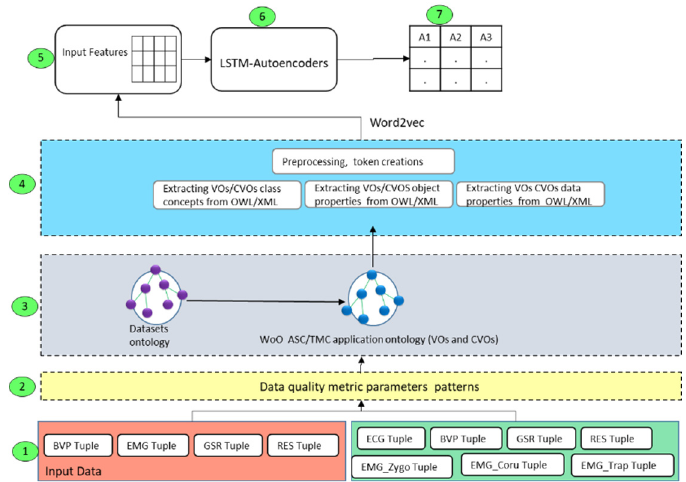
Figure 25. Contextual data quality processing workflow. Table 1. Experimental test cases datasets detail.